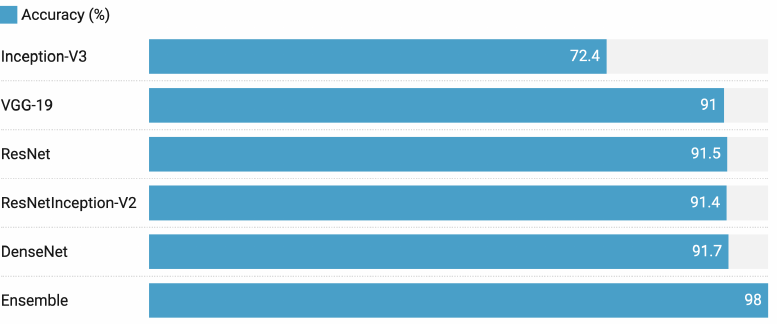
Figure 5. Accuracy comparison of individual learners and their ensemble